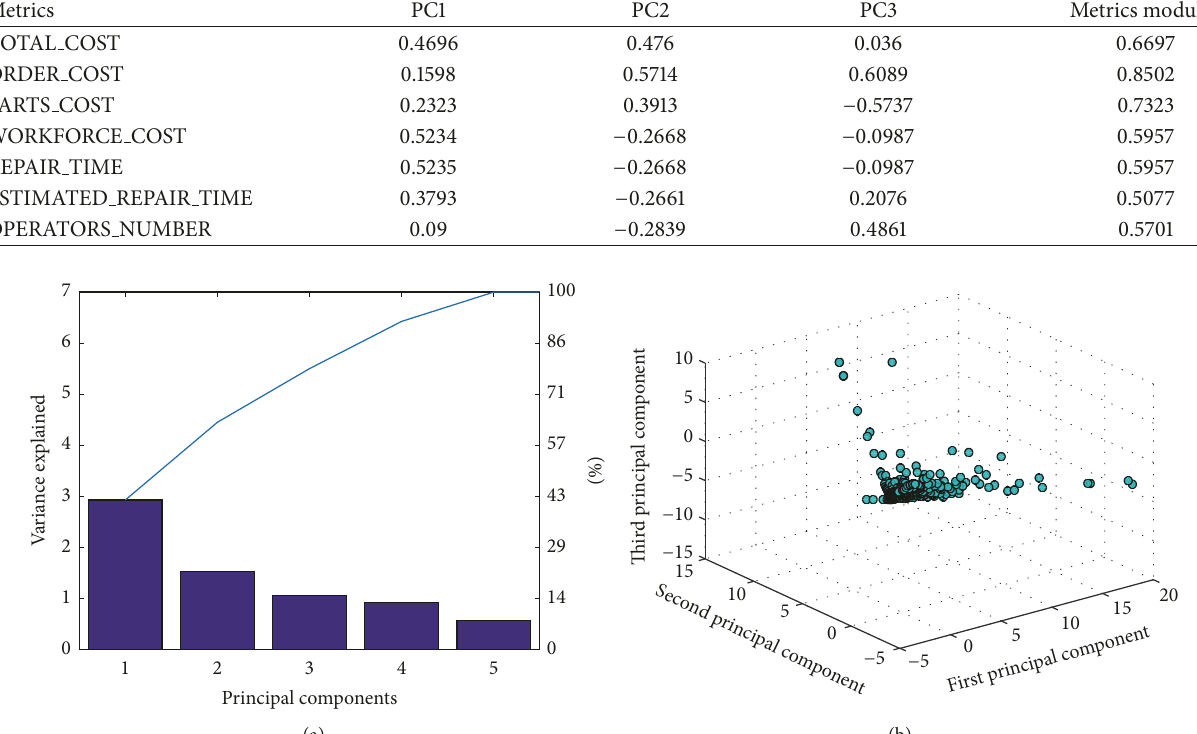
Table 3: PCA results. Principal components values.